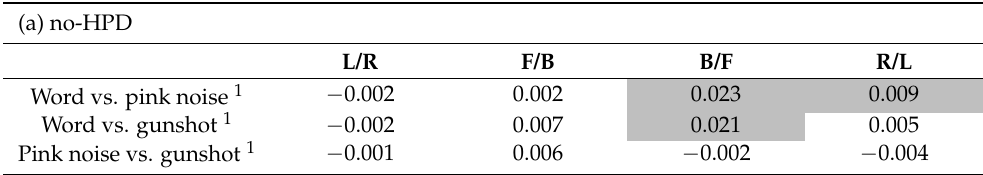
Table 6. Comparisons of mirror image reversal errors in each hemifield for the (a) no-HPD condition (LSD analyses between stimuli) and (b) HPD condition (main effects for each HPD, and post-hoc LSD analyses between stimuli for each HPD).